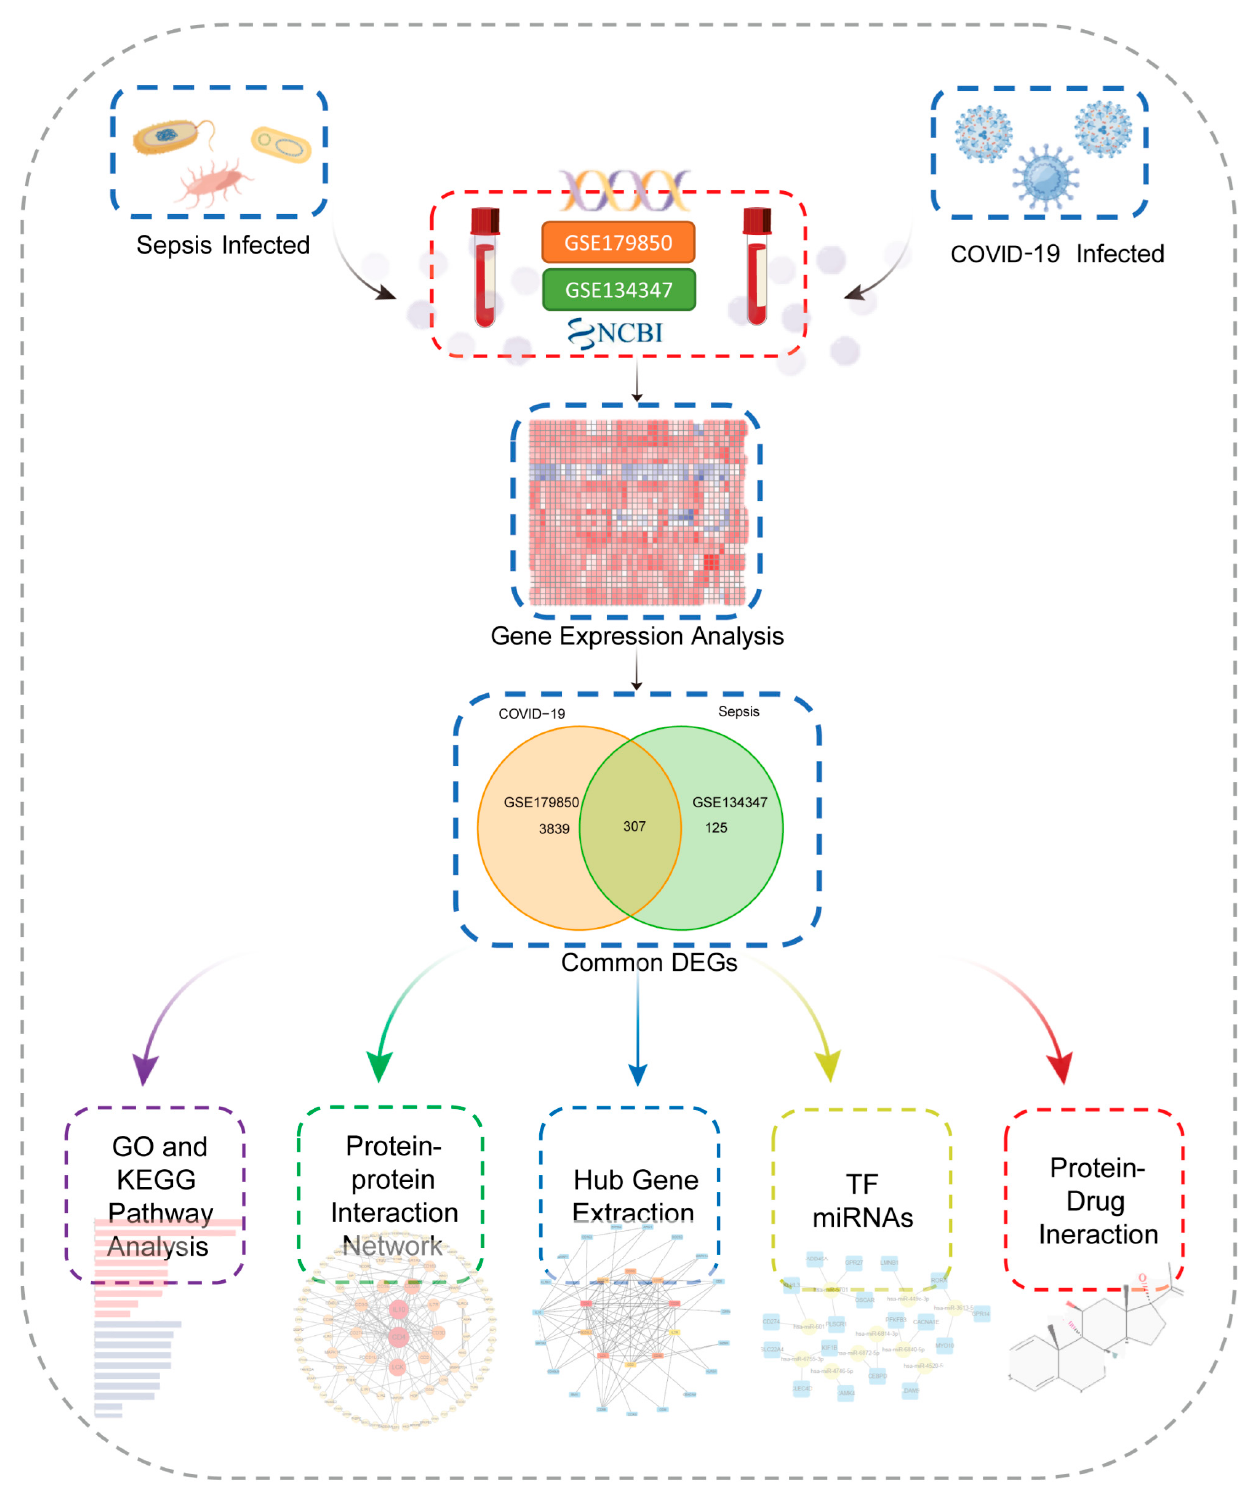
Figure 1. This is a diagram of the entire study workflow.